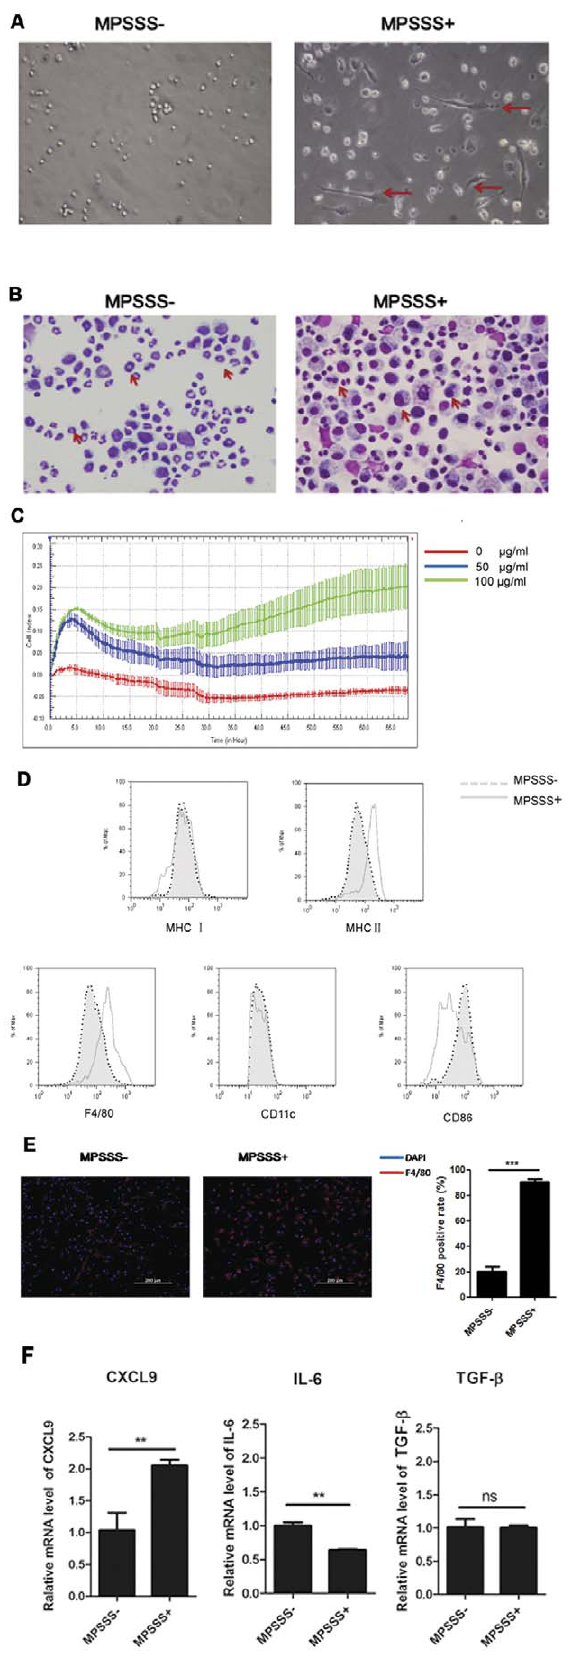
Figure 3. MPSSS promoted differentiation of MDSCs. (A) FACS- sorted splenic MDSCs from McgR32 tumor-bearing mice with or without MPSSS stimulation were viewed with bright-field illumination, (original magnification 6 200) and (B) after Wright’s staining for nuclei (original magnification 6 200). (C) Electrical impedance measured using a real-time cell electronic sensing (RT-CES) system. (D) All adherent splenocytes from McgR32 tumor-bearing mice were cultured with or without MPSSS for 72 hours and the expression of MHC I, MHC II, F4/80, CD11c or CD86 on MDSCs were analyzed by FACS. (E) Immunofluores- cent staining of F4/80 on MPSSS-treated MDSCs (original magnification 6 100). (F) Purified MDSCs were stimulated with MPSSS for 4 hours, and the expression of CXCL9, IL-6, or TGF- b mRNA was determined by RT- PCR. Results were given relative to b -actin mRNA and are presented as means 6 SD of triplicate samples from one representative experiment. Data is analyzed with Student’s t- tests. * P , 0.05, ** P ,